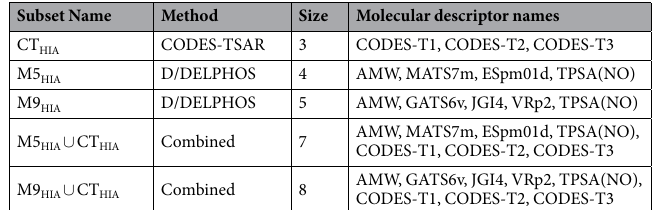
Table 3. Molecular descriptor subsets used for inferring the human intestinal absorption QSAR models.